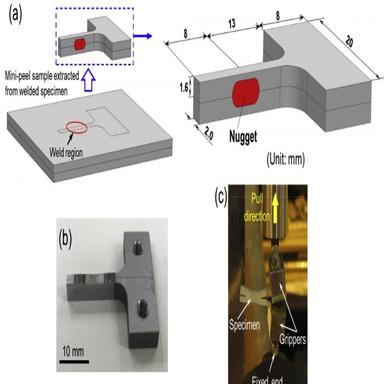
Mini-peel test. (a) Location of the sample in a spot welded joint and dimensions; (b) physical image of the sample; (c) close-up view of the mini-peel apparatus.